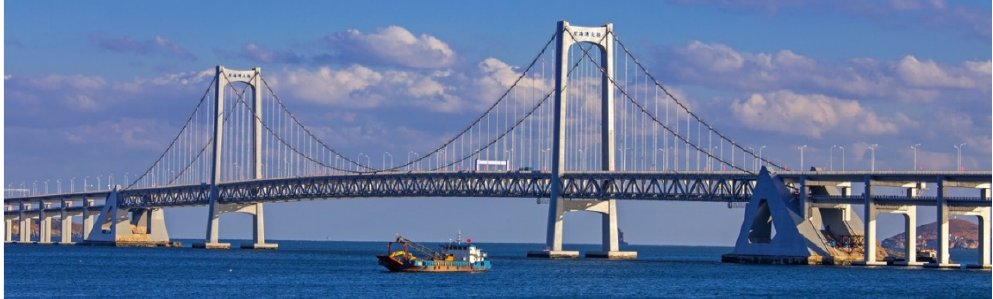
Figure 1. Dalian Xinghai Bay Sea-crossing Bridge.